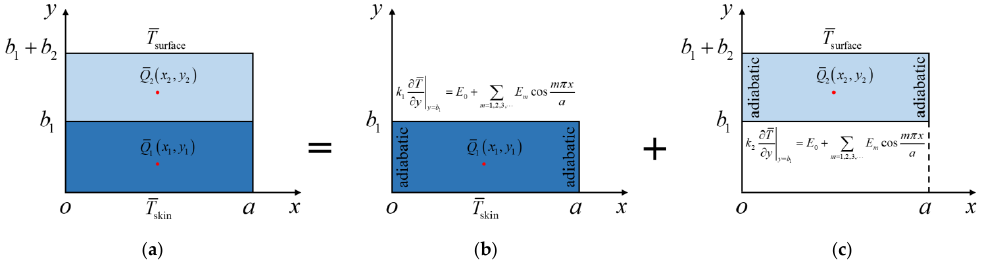
Figure 3. SSM procedure for bi-layered transient heat conduction with two arbitrarily positioned point heat sources. ( a ) General problem. ( b ) Subproblem for Layer 1. ( c ) Subproblem for Layer 2.